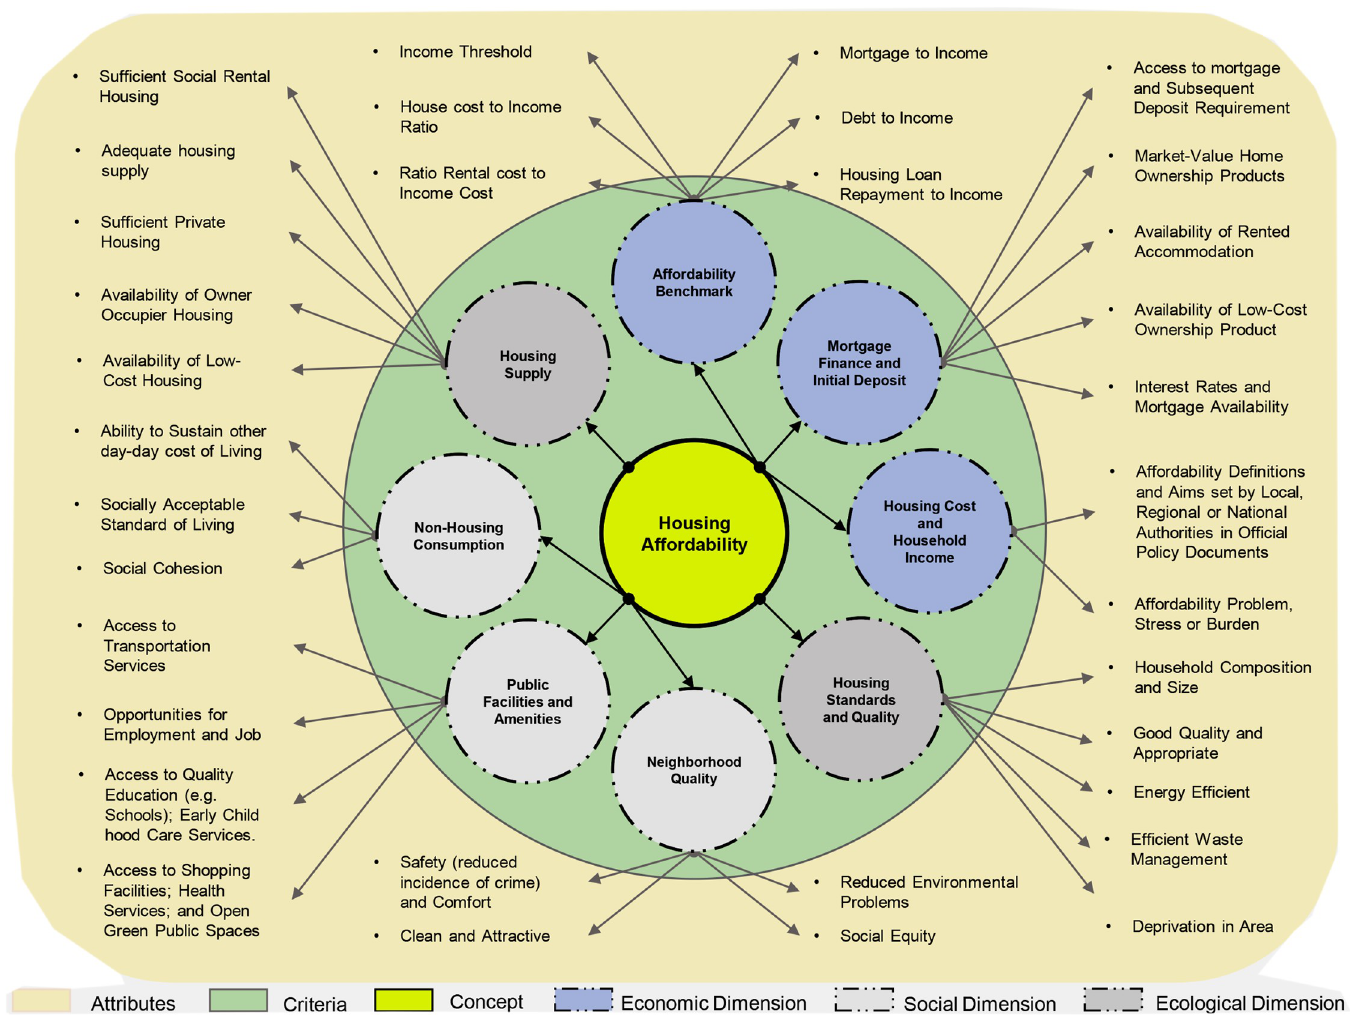
Fig 2. A conceptual model for understanding the HA concept. (Source: Adapted from [4,6,7].